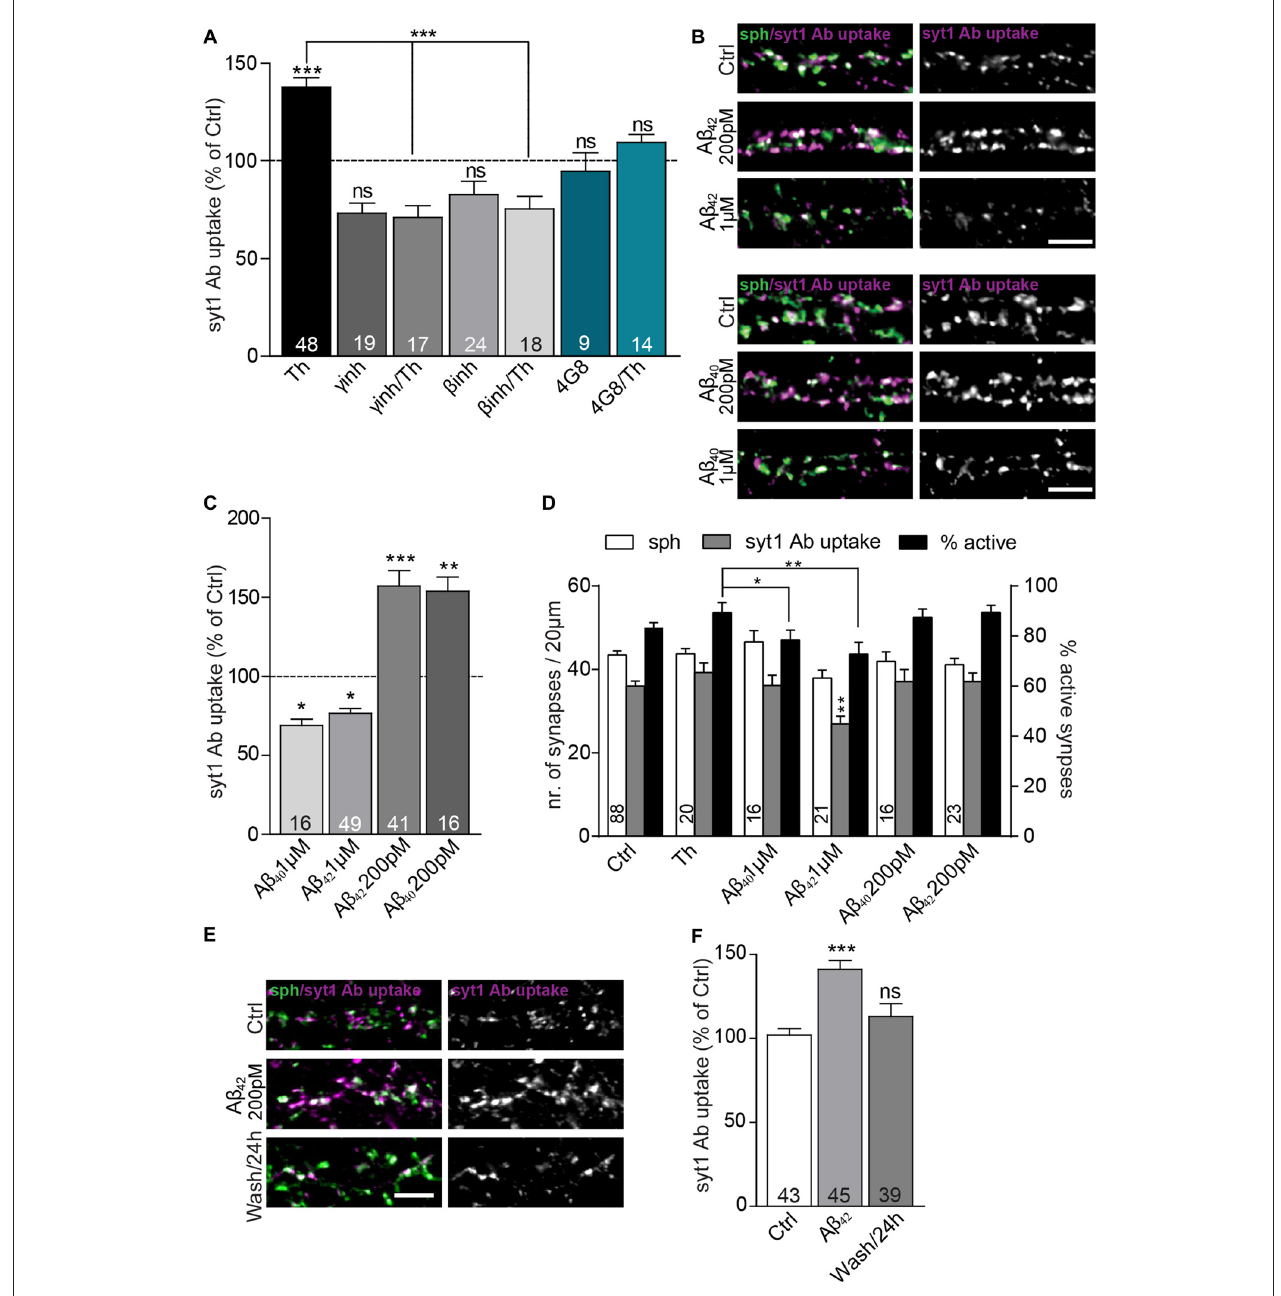
FIGURE 2 | Extracellular A β 40 and A β 42 have a hormetic effect on presynaptic vesicle recycling. (A) Quantification of activity-driven syt1 Ab uptake from Th-treated vs. control cells in the presence or absence of A β antibody (4G8) and inhibitors of enzymes involved in amyloid precursor protein (APP) processing ( β -secretase and γ -secretase inhibitors). Numbers within bars display the number of analyzed visual fields pooled from five (Th), three ( β inh; γ inh) and two (4G8) independent cell culture preparations. (B) Representative images of cultured cortical neurons treated either with pM or µ M concentration of A β 40 , A β 42 or control solution and stained with syt1 Ab (magenta) and sph (green). (C) Quantification of (B) . Numbers indicate the number of individual cells used for analysis obtained from four (A β 42 ) and two (A β 40 ) culture preparation. (D) Quantification of density of sph-positive synapses (white bars), active synapses with syt1 Ab uptake (gray bars) and quantification of percentage of active synapses (black bars) in cultures treated with vehicle, Th and 200 pM and 1 µ M A β 40 and A β 42 . Numbers in columns indicate number of analyzed cells coming from at least two independent cell preparations. (E) Representative images of cortical neurons treated with control or 200 pM A β 42 as well as cells assayed 23 h after A β 42 washout for network activity-driven syt1 Ab uptake. (F) Quantification of the experiment in (E) . Numbers within columns show the number of the cells used for analysis from at least two independent cell culture preparations. In all graphs values are expressed as the mean ± SEM. The density of synapses were analyzed using one-way ANOVA with Bonferroni post hoc test, all other data were analyzed using Kruskal-Wallis test followed by Dunn’s multiple comparison test, ∗ p < 0.05, ∗∗ p < 0.01, ∗∗∗ p < 0.001. Scale bar, 5 µ m.